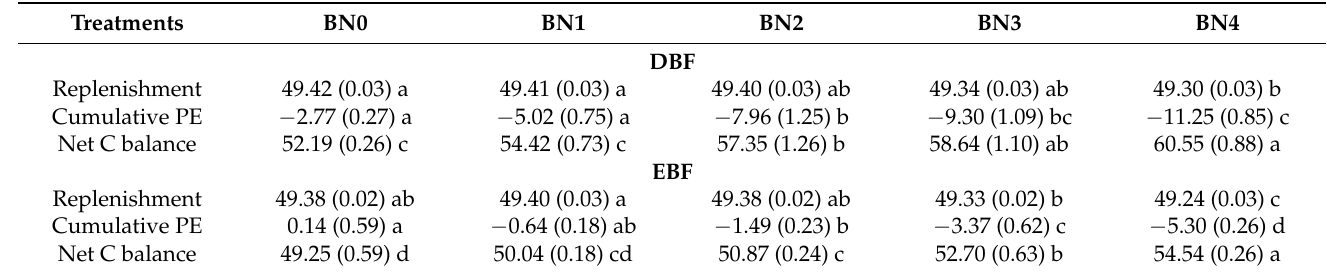
Figure 3. Relationships between net C balance and N addition rates in three forests. Table 2. Effects of N addition on replenishment (g C kg − 1 SOC), cumulative PE (g C kg − 1 SOC) and net C balance (g C kg − 1 SOC) after a 365-day incubation. Values are means and standard errors (n = 4). Significant differences between the mean values of the treatments in each row are indicated by different lowercase letters ( p < 0.05).